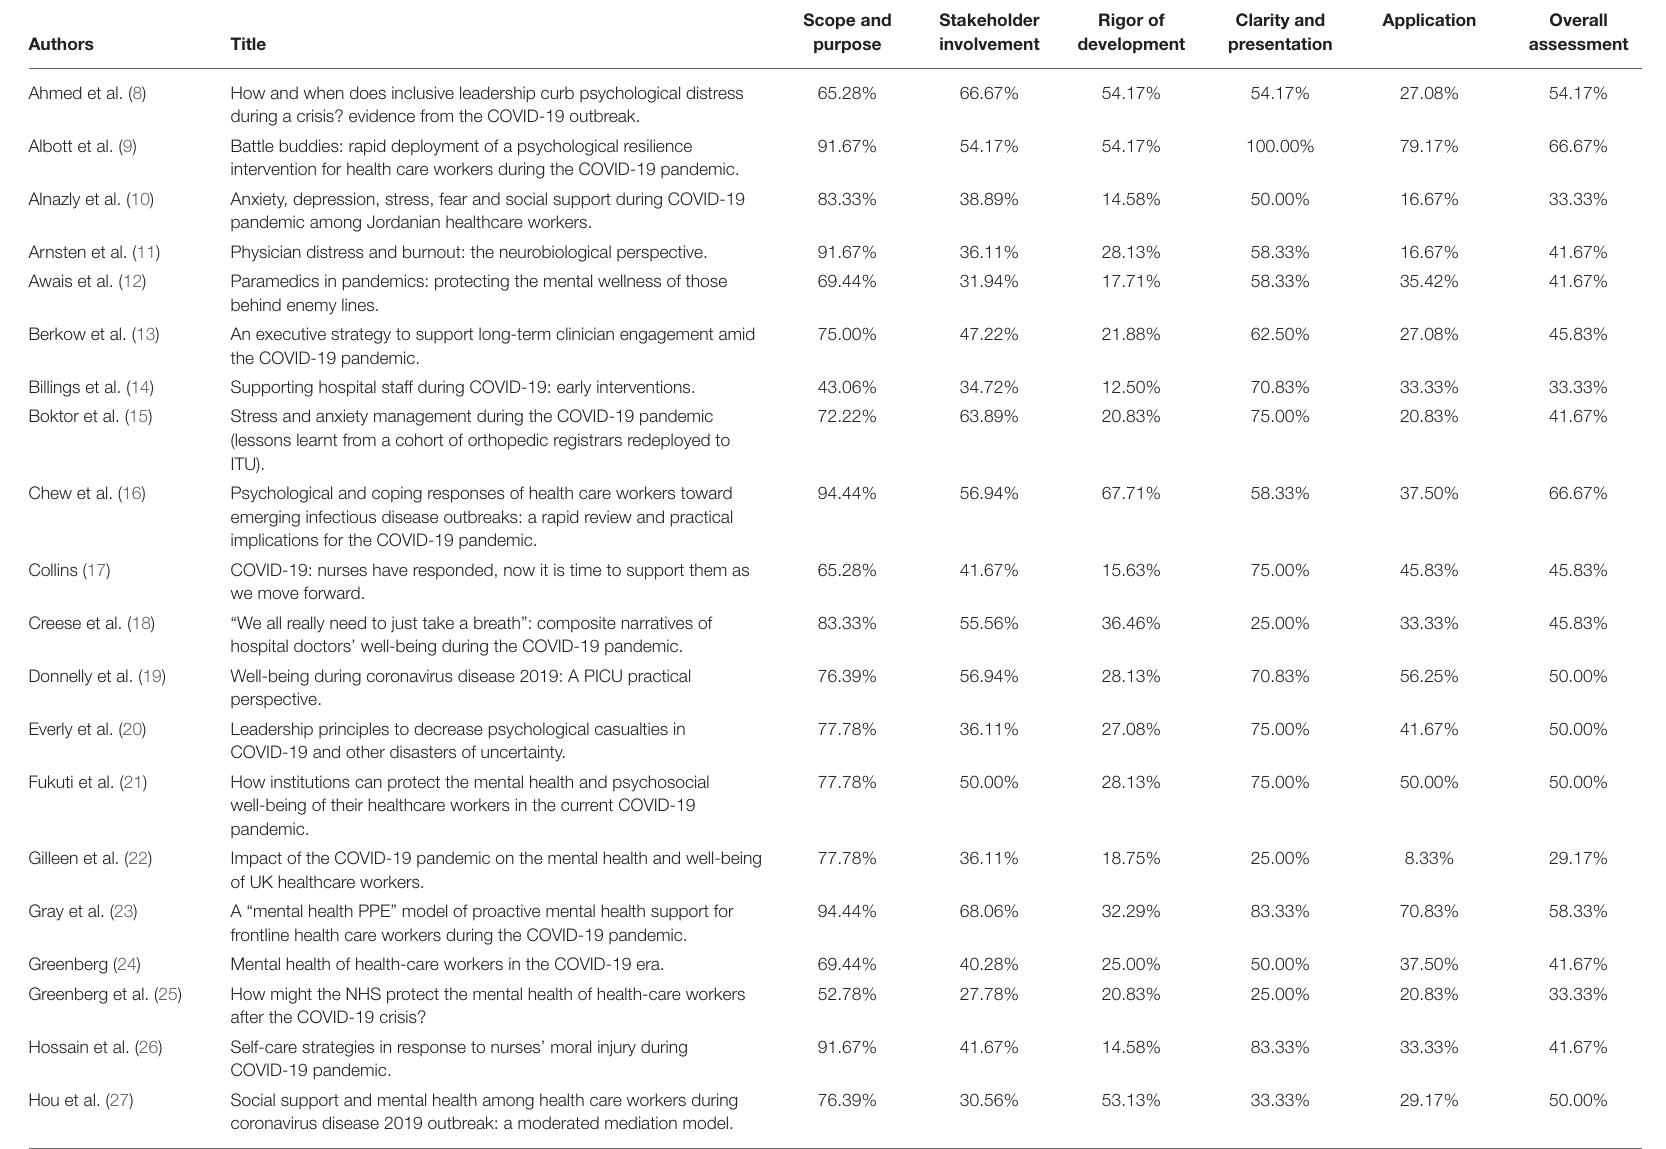
TABLE 1 | Domain scores calculated according to the AGREE II methodology for each of the included articles. assessmentAuthors